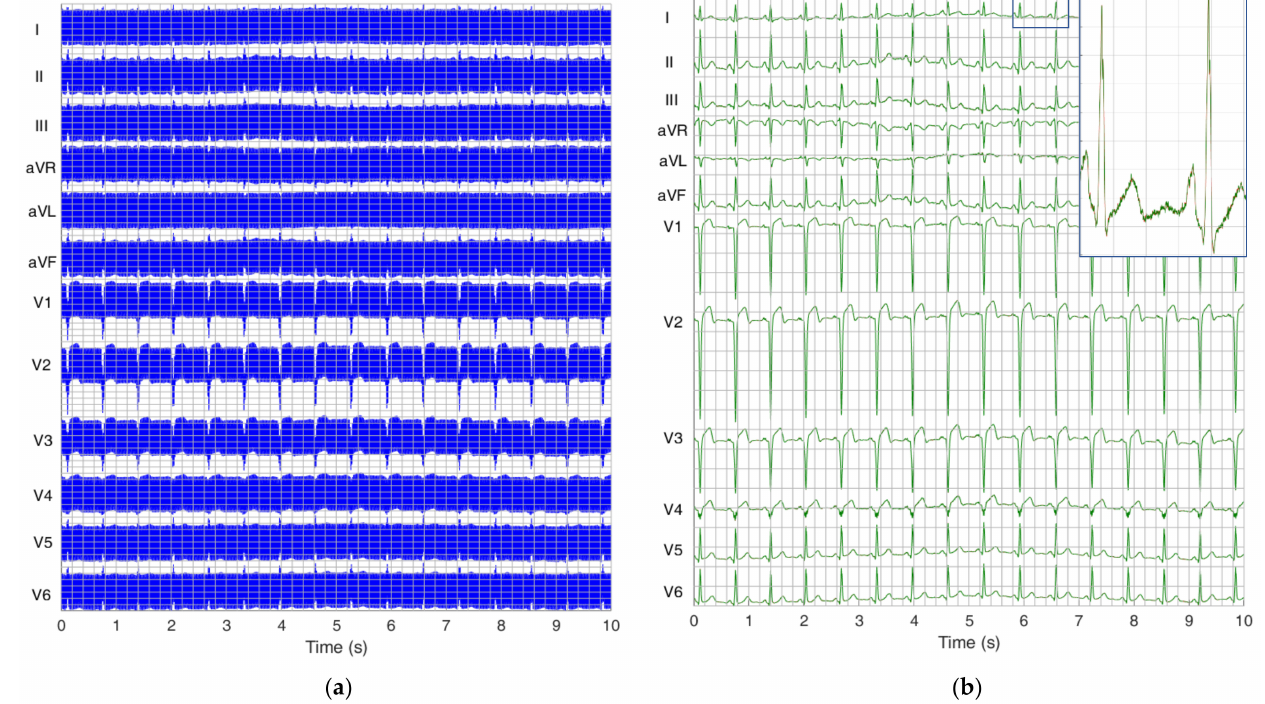
Figure 16. Example of 10 s 12-lead ECG trace (s0137lre.dat from PTB Diagnostic ECG database) shown in a grid (200 ms/div, 500 µ V/div): ( a ) 12-lead ECG superimposed by PLI with extreme amplitude (1000 µ V r.m.s.) and linearly changing frequency (slew rate = 0.1 Hz/s, range = 50–51 Hz over 10 s); ( b ) filtered 12-lead ECG by SF algorithm with 10 × zoomed segment of lead I (1 s, 50 µ V/div), showing the overlap between original ECG (red) and filtered ECG (green). The y-scaling of 12 ECG leads retains no inter-lead overlap; thus, ECG in ( b ) is a zoomed-in representation of ( a ) after filtering of the large PLI